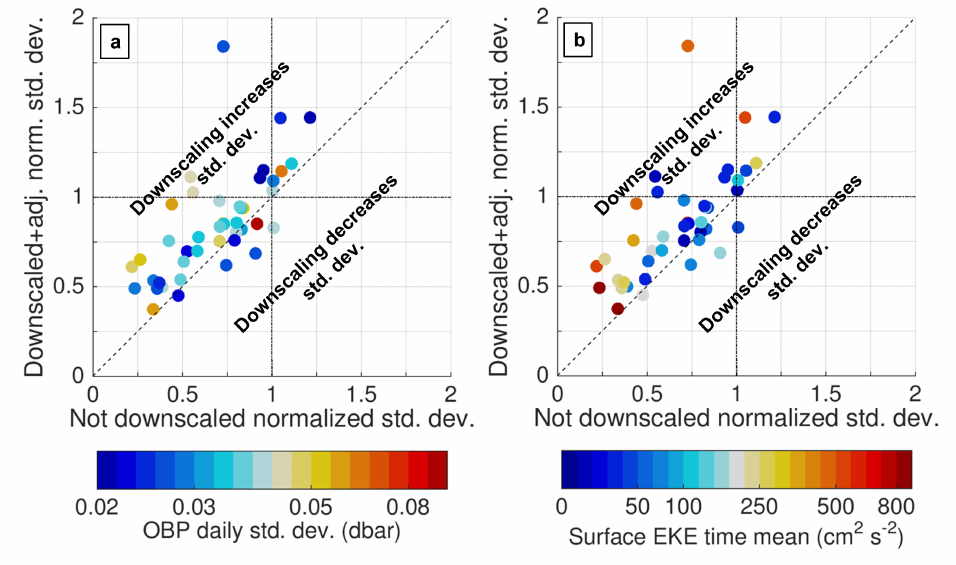
Figure 7. Scatter plots of standard deviations of not downscaled and downscaled+adjusted GRACE- based point OBPs, normalized by in situ BPR standard deviations at the same sites, 3–12 month timescales. The x-axis indicates the normalized standard deviation without downscaling of the GRACE data; the y-axis indicates the correlation with the depth-adjusted downscaled GRACE data. Color shading of the circles is according to ( a ) OBP daily standard deviations with no temporal filtering, and ( b ) surface EKE, following Figure